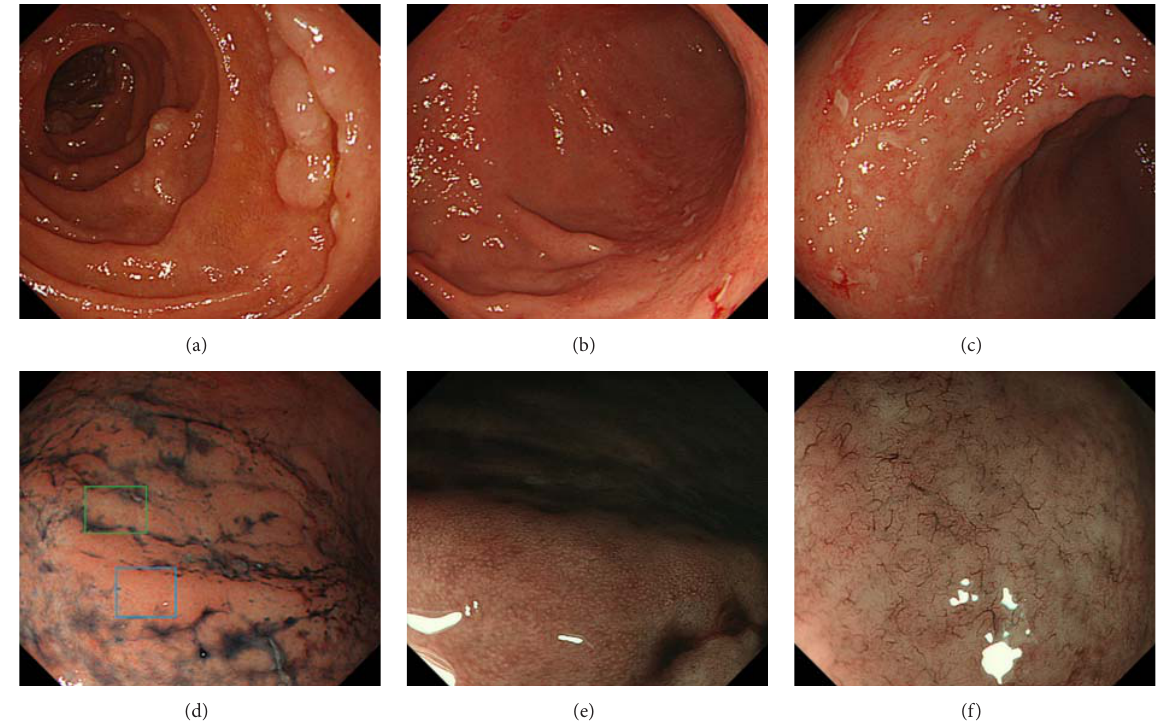
Figure 3: Endoscopic images from case 2. Esophagogastroduodenoscopy revealed multiple whitish depositions in the duodenum (a). In the stomach, multiple erosions in the body and angle were observed (b, c). There were no erosions in the greater curvature of the gastric body (d). Magnifying endoscopic observation with narrow-band imaging of the gastric body ((d), blue square) showed that the gastric pits were only partially preserved (e). Imaging a second area ((d), green square) showed destruction of gastric pits and branched abnormal vessels (f).